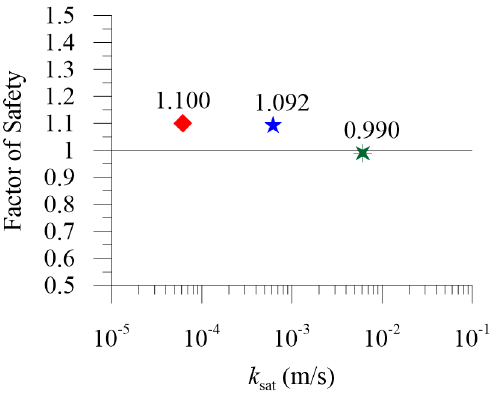
Figure 9. Factor of safety variation versus permeability coefficient k sat.